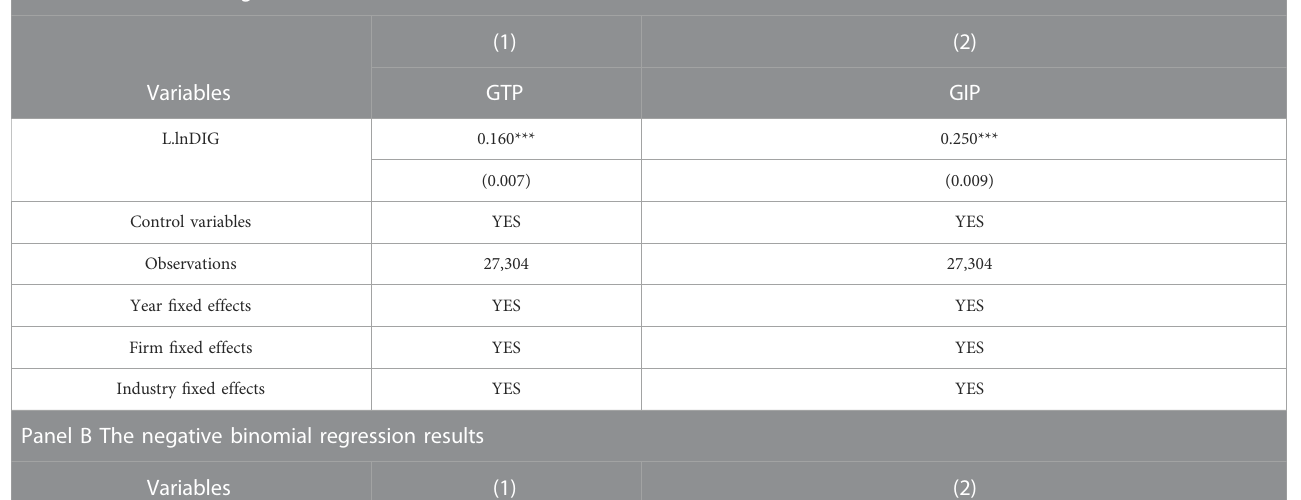
TABLE 6 Considering count dependent variables. Panel A The Poisson regression